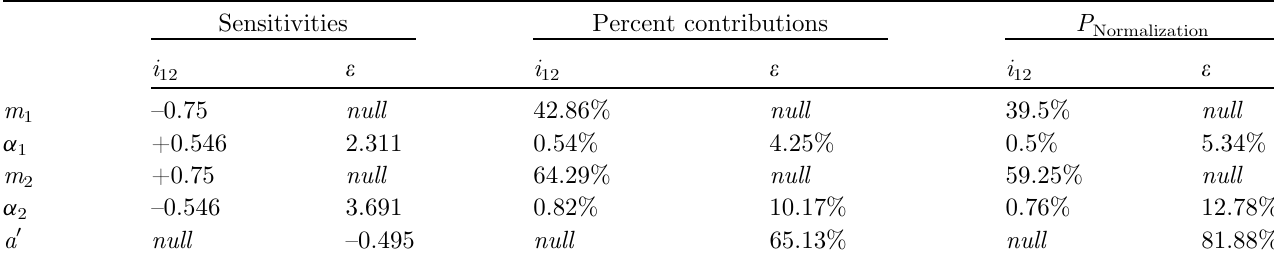
Table 1. Results of sensitivities and percent contributions. Sensitivities